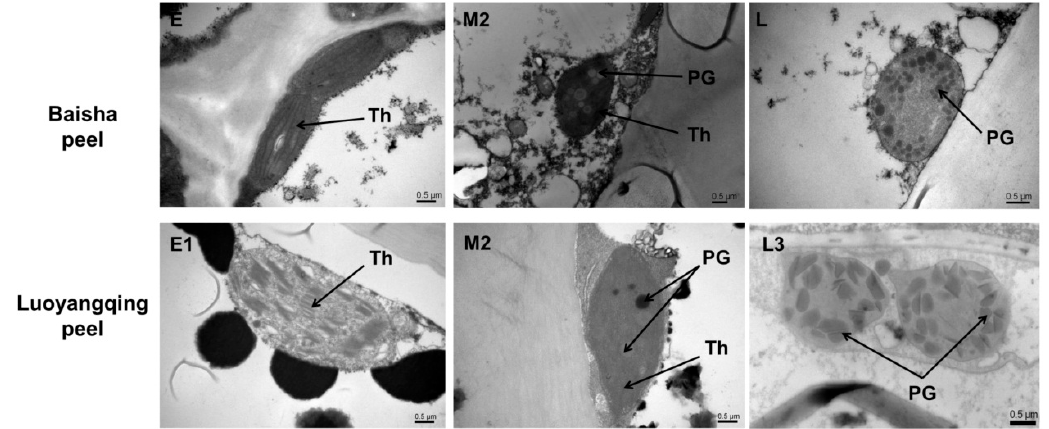
Figure 3. Ultrastructure of plastid of Luoyangqing and Baisha loquats in the peel cells of fruits at early, middle, and late maturity stages. Bar = 0.5 µ m. Th: thylakoid; PG: plastoglobule.